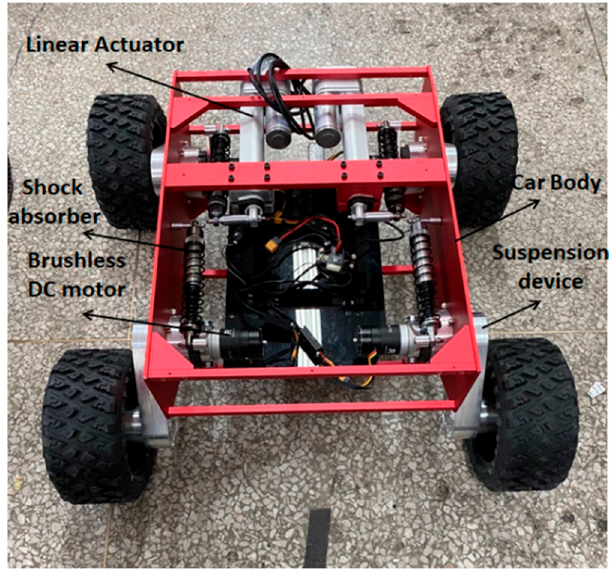
Figure 13. Prototype of the WLHR.